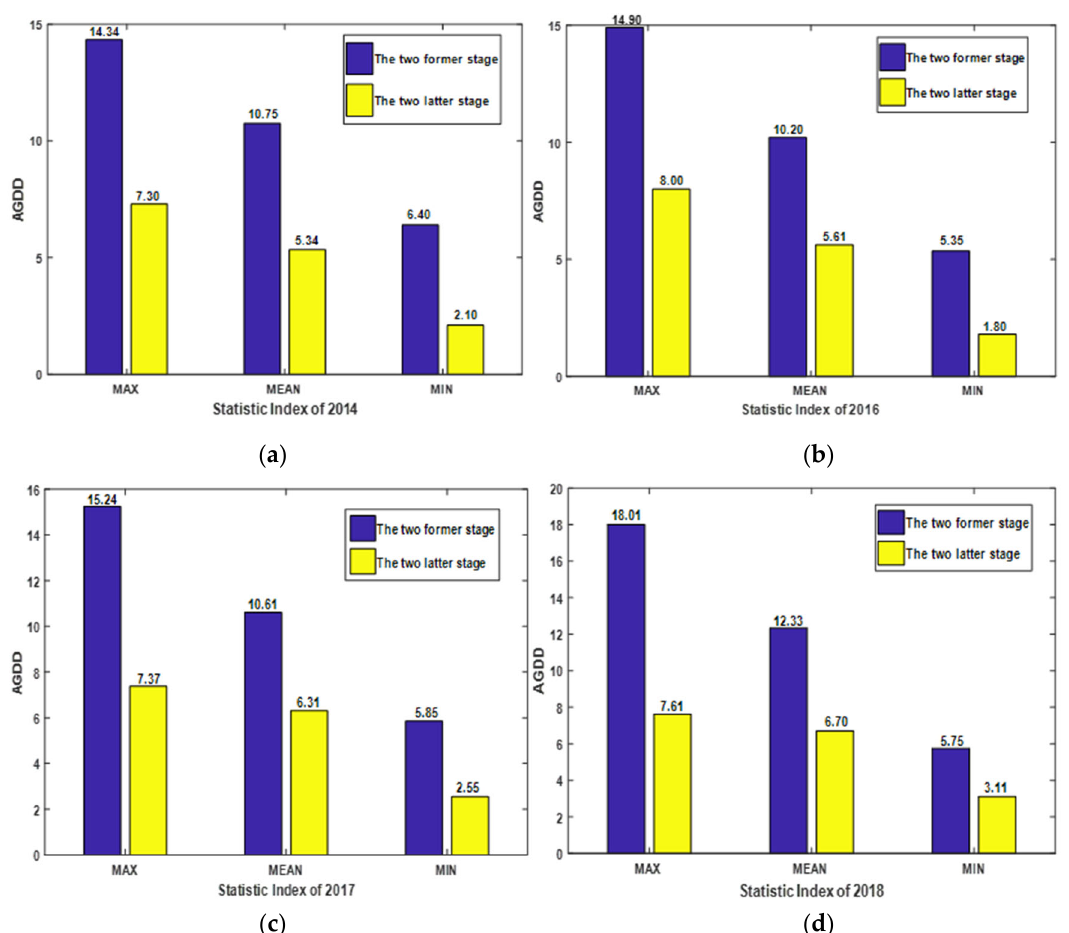
Figure 6. Comparison of statistical indicators of the first two phenological periods and the last two phenological periods of each year. ( a – d ) indicate the statistical indicators of each year. The blue bars indicate the period between the reviving and tillering stages, while the yellow bars indicate the period between the heading and anthesis stages.